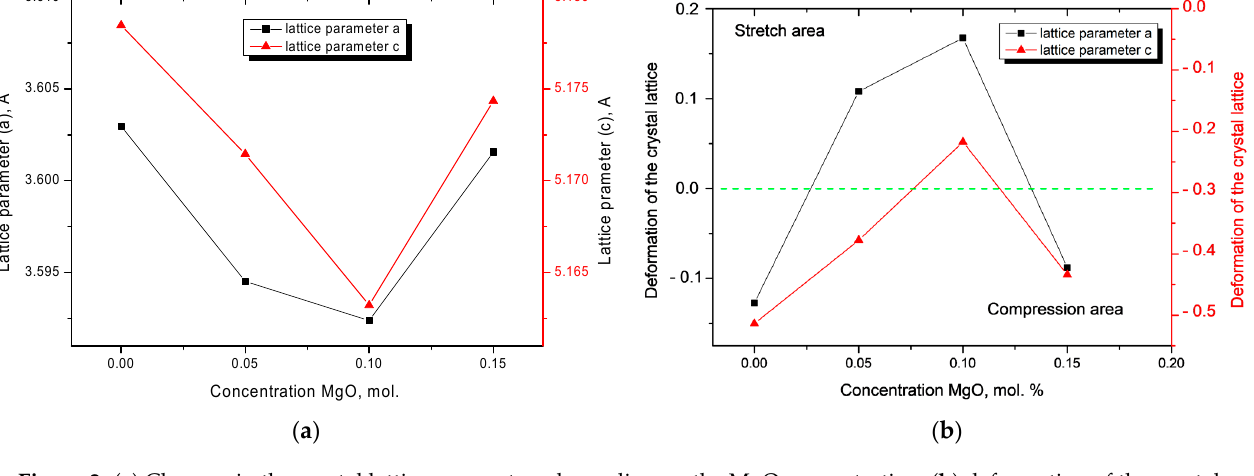
Figure 2. ( a ) Changes in the crystal lattice parameters depending on the MgO concentration; ( b ) deformation of the crystal lattice depending on the MgO concentration.